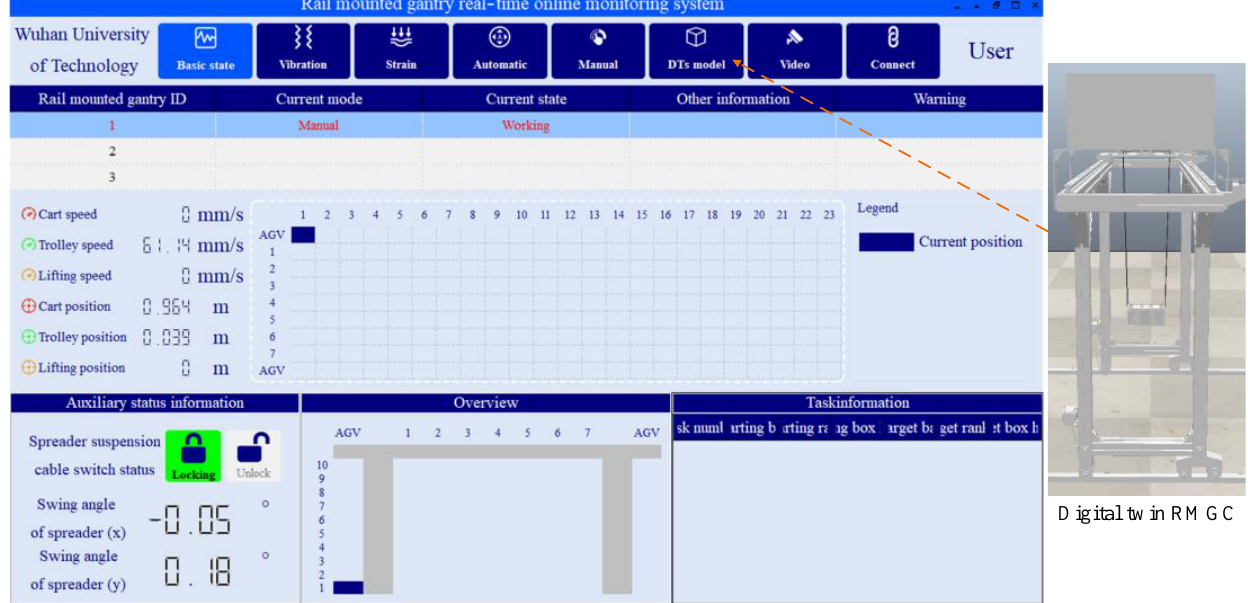
Figure 12. Comparison of swing angle curves obtained by simulation under different working